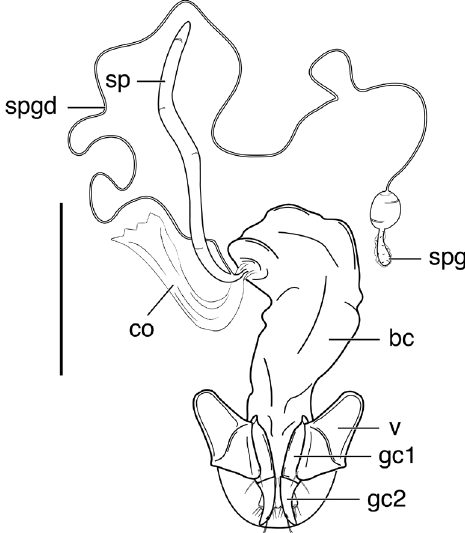
Figure 20. Line drawing of female reproductive tract of Selenophorus latior species group, in part, S. latior Dar- lingtoni, ventral aspect. Legend: bc bursa copulatrix co common oviduct gc1 gonocoxite 1 gc2 gonocoxite 2 sp spermatheca spg spermathecal gland spgd spermathecal gland duct v valvifer. Scale bar 1